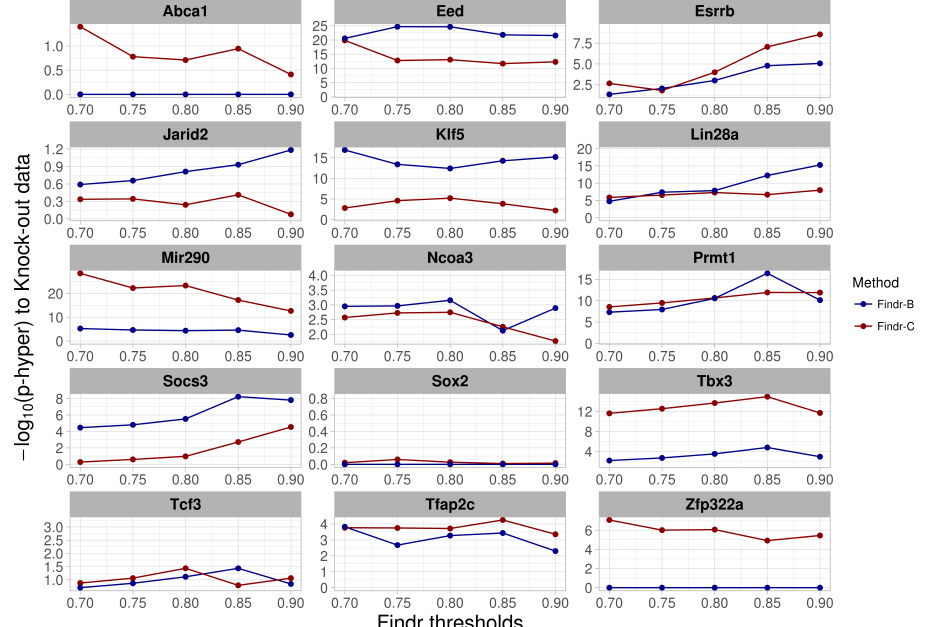
Figure 3. Robustness of Findr performance demonstrated by using different score